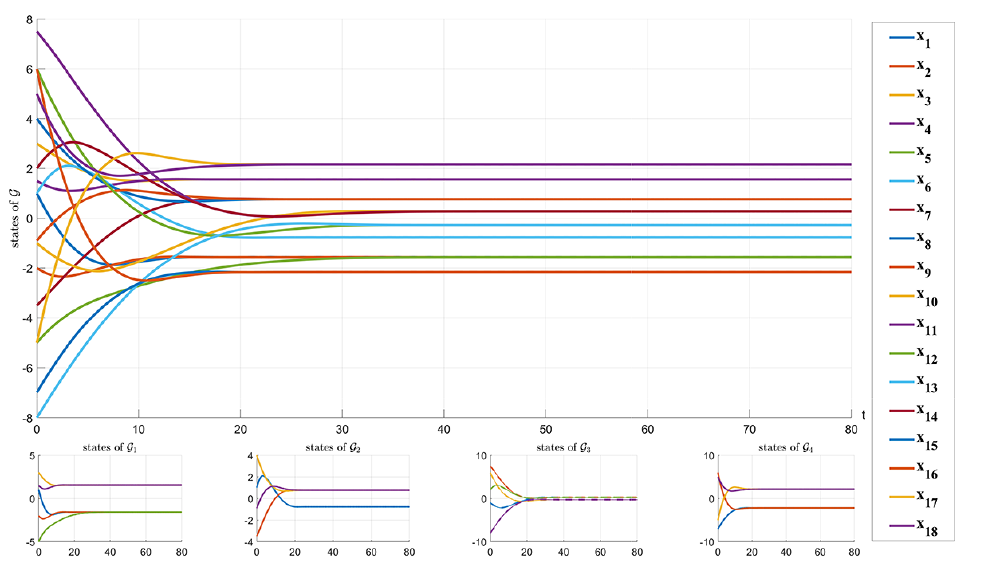
Figure 6. Simulation result relating to topology in Figure 2 and α =